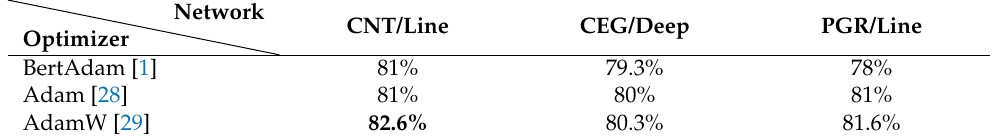
Table 4. Experimental results with different optimizers when fine-tuning the COPA-Test dataset.